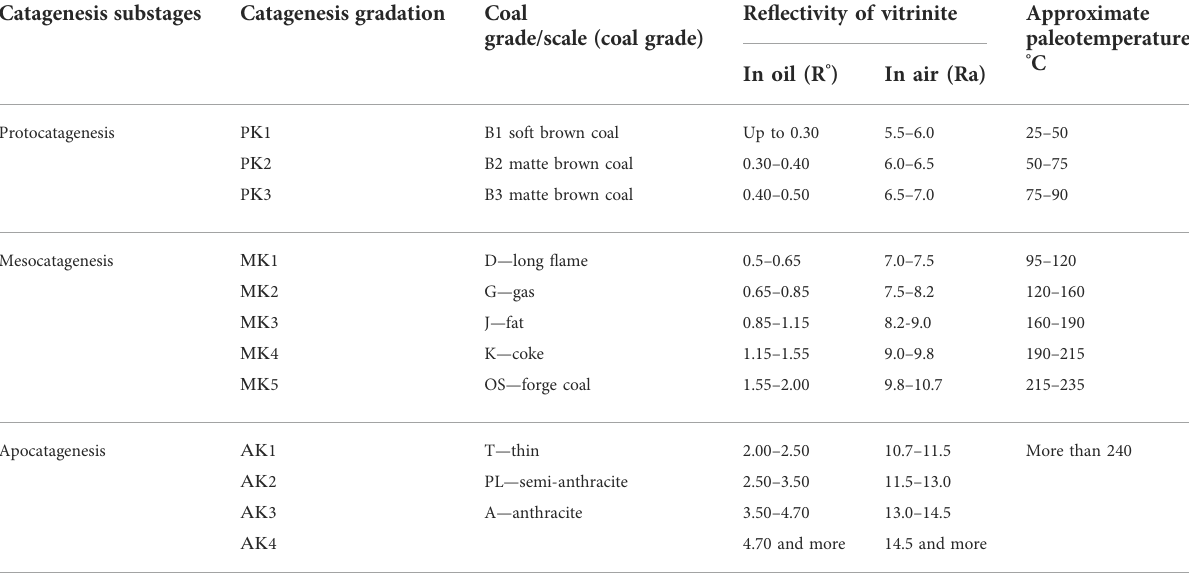
TABLE 2 Scale of catagenesis and coali fi cation of OM of the rocks.